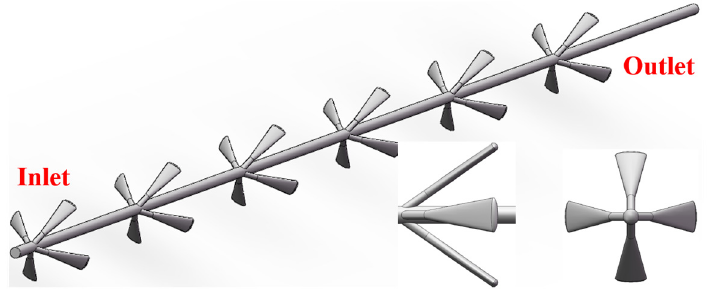
Figure 10. The schematic of the inserts in the circular tube.